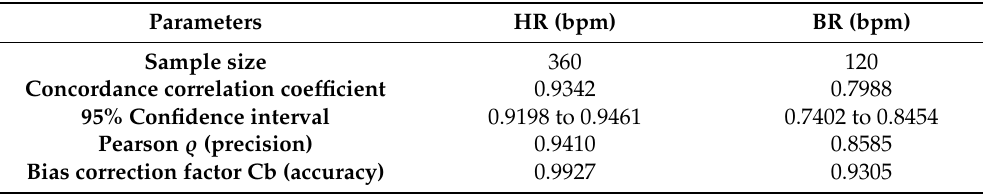
Table 3. Concordance correlation coefficients.